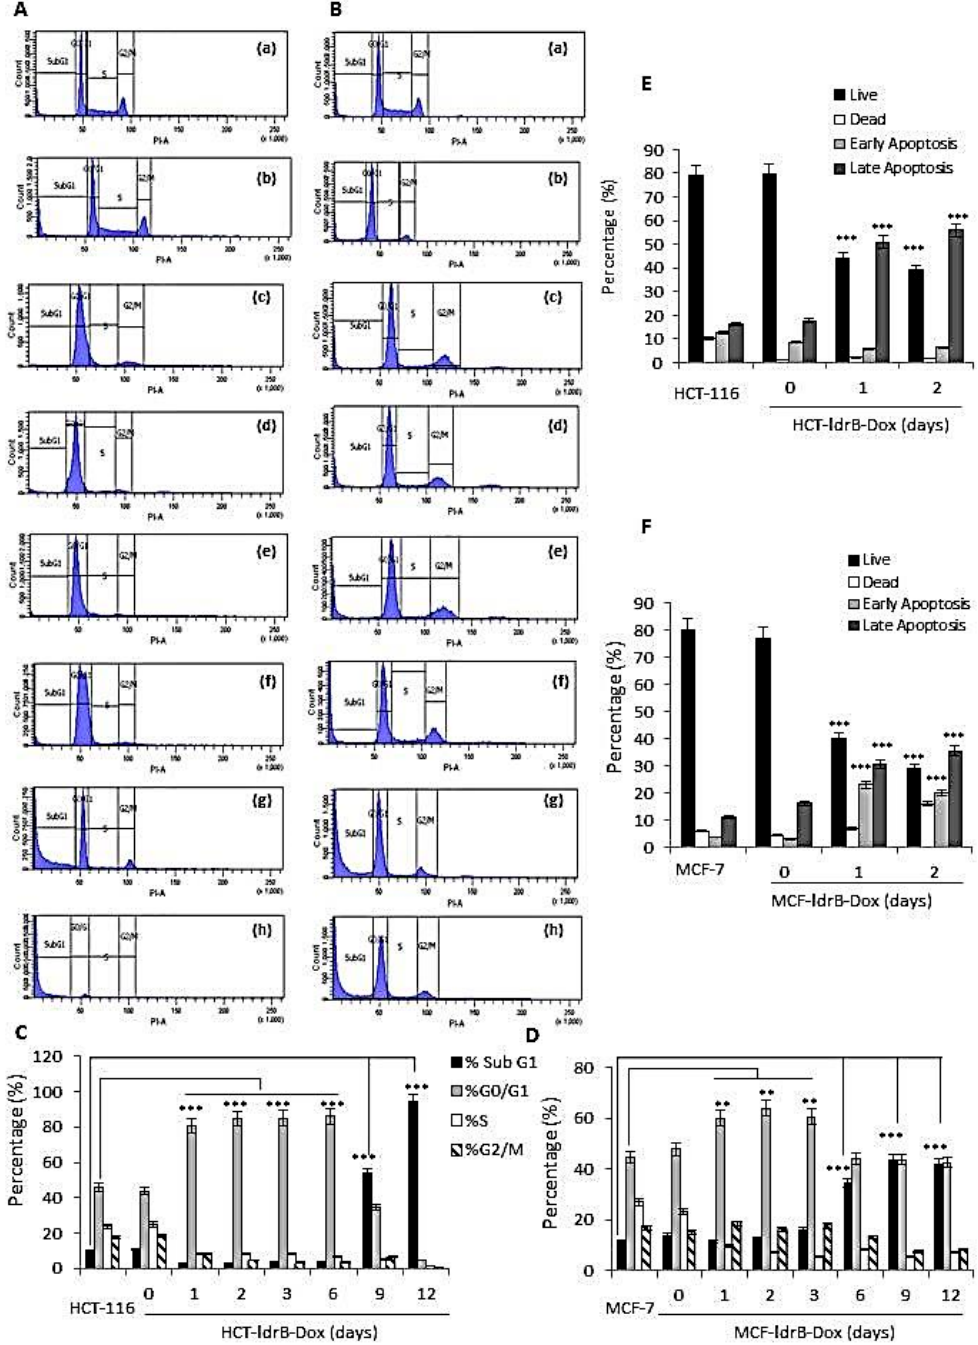
Figure 3. ldrB gene induced cell cycle arrest in G0 / G1 and apoptosis in both HCT-116 and MCF-7 cell lines. ( A ) Cell cycle analysis of HCT-116 cells treated with the ldrB gene after staining with propidium iodide. (a) HCT-116, (b) HCT-ldrB, and (c)–(h) HCT-ldrB after 1, 2, 3, 6, 9, and 12 d of Dox induction, respectively. ( B ) Cell cycle analysis of MCF-7 cells treated with the ldrB gene after staining with propidium iodide. (a) MCF-7, (b) MCF-ldrB, and (c)–(h) MCF-ldrB after 1, 2, 3, 6, 9, and 12 d of Dox induction, respectively. ( C ) Percentage of HCT-116 and HCT-ldrB-Dox cells in sub-G1, G0 / G1, S, and G2 / M phases. ( D ) Percentage of MCF-7 and MCF-ldrB-Dox cells in sub-G1, G0 / G1, S, and G2 / M phases. ( E ) Late apoptosis is enhanced by ldrB gene expression in HCT-116 and ( F ) MCF-7 cells. Data are expressed as the mean ± SD of the mean of three independent experiments (** p < 0.01 vs. control and *** p < 0.001 vs.